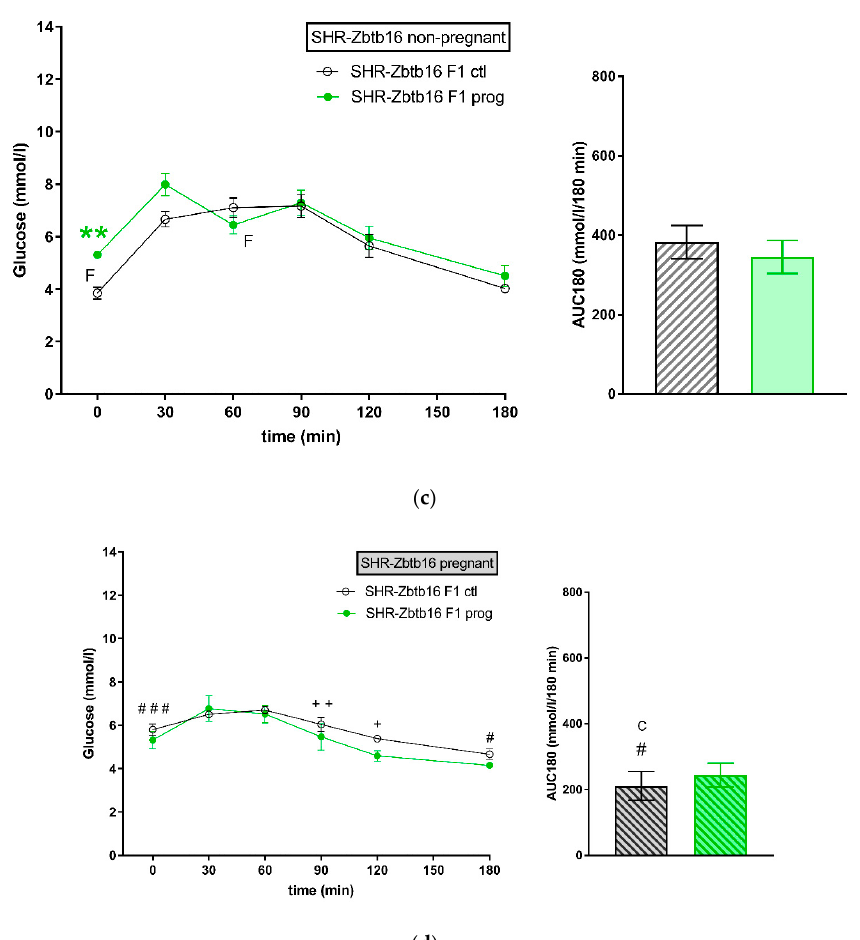
Figure 2. The oral glucose tolerance test (OGTT). The course of glycaemic curves in rat dams in adulthood one week prior ( a , c ) and during pregnancy ( b , d ); SHR F1 controls—black boxes, F1 programmed SHR—blue boxes, SHR-Zbtb16 F1 controls—white circles, F1 programmed SHR-Zbtb16—green circles. Data are expressed as mean ± SEM. The strain comparison using the post-hoc Fisher’s least significant di ff erence test of the two-way ANOVA for STRAIN and PROGRAM as major factors are indicated as follows: * p < 0.05, ** p < 0.01, *** p < 0.001. E ff ect of programming in SHR and SHR-Zbtb16 strains is represented by blue and green asterisks (*), respectively. ( a ) C represents STRAIN di ff erences between SHR and SHR-Zbtb16 F1 controls in adulthood before the pregnancy, t = 30 min CCC p < 0.001 , t = 60 min C p < 0.05 , AUC180 CC p < 0.01, which were all higher in SHR; ( b ) # represents di ff erences in non-pregnant and pregnant SHR F1 controls (e ff ect of pregnancy), t = 0 min ## p < 0.01, higher in pregnant SHR F1 controls, t = 30 min ##, AUC180 ### p < 0.001 , higher in non-pregnant SHR F1 controls, + represents di ff erences in non-pregnant and pregnant SHR F1-programmed dams (e ff ect of pregnancy), t = 0 min ++ p < 0.01 , t = 90 min ++ , which were all higher in non-pregnant SHR F1-programmed dams; ( c ) F represents strain di ff erences between SHR and SHR-Zbtb16 F1-programmed dams in adulthood before the pregnancy, t = 0 min *, t = 60 min *, which were both higher in SHR F1-programmed dams; ( d ) C represents STRAIN di ff erences between SHR and SHR-Zbtb16 F1 pregnant controls, AUC180 C p < 0.05, which was higher in SHR F1 controls, # represents di ff erences in non-pregnant and pregnant SHR-Zbtb16 F1 controls (e ff ect of pregnancy), t = 0 min ### p < 0.001, t = 180 min # p < 0.05, higher in pregnant SHR-Zbtb16 F1 controls, AUC180 # p < 0.05, higher in non-pregnant SHR-Zbtb16 F1 controls, + represents di ff erences in non-pregnant and pregnant SHR-Zbtb16 F1-programmed dams (e ff ect of pregnancy), t = 90 min ++ p < 0.01, t = 120 min + p < 0.05, which were all higher in non-pregnant SHR-Zbtb16 F1-programmed